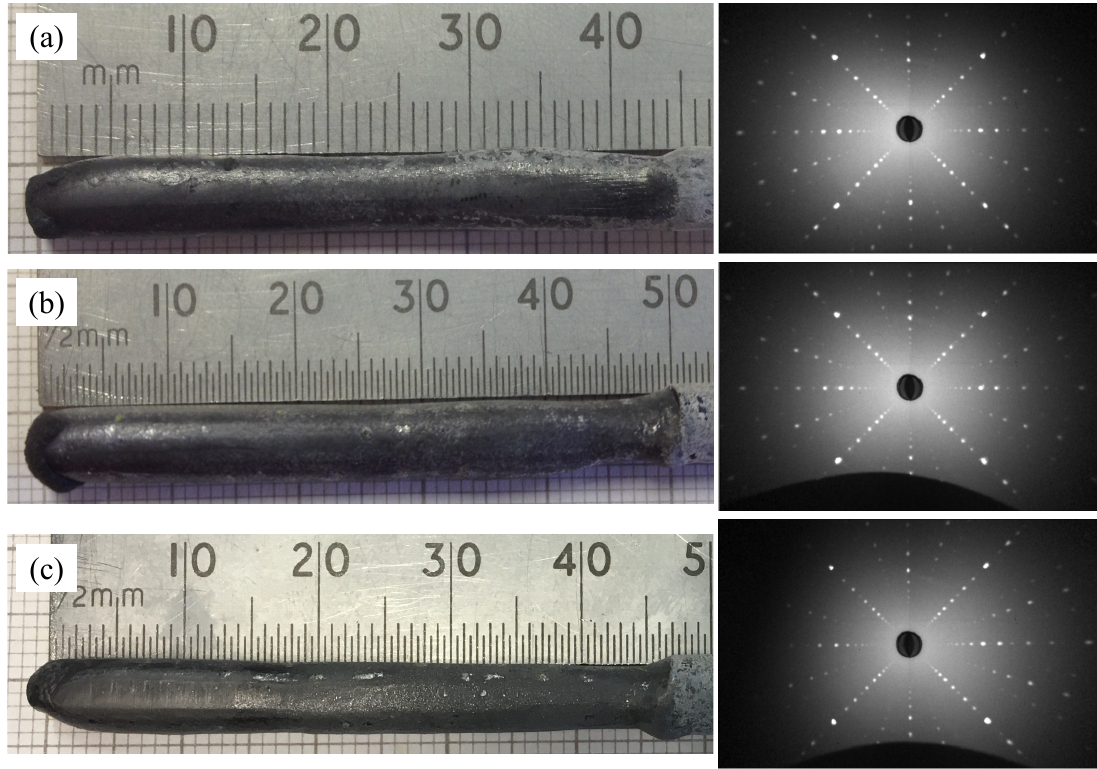
Figure 1. Crystal boules of ( a ) Sm 0.95 Ce 0.05 B 6 , ( b ) Sm 0.90 Ce 0.10 B 6 and ( c ) Sm 0.80 Ce 0.20 B 6 , prepared by the floating-zone method in argon atmosphere at a growth rate of 18 mm/h. X-ray Laue back reflection photographs show the [001] orientation of aligned Sm 1 − x Ce x B 6 samples used for the physical properties